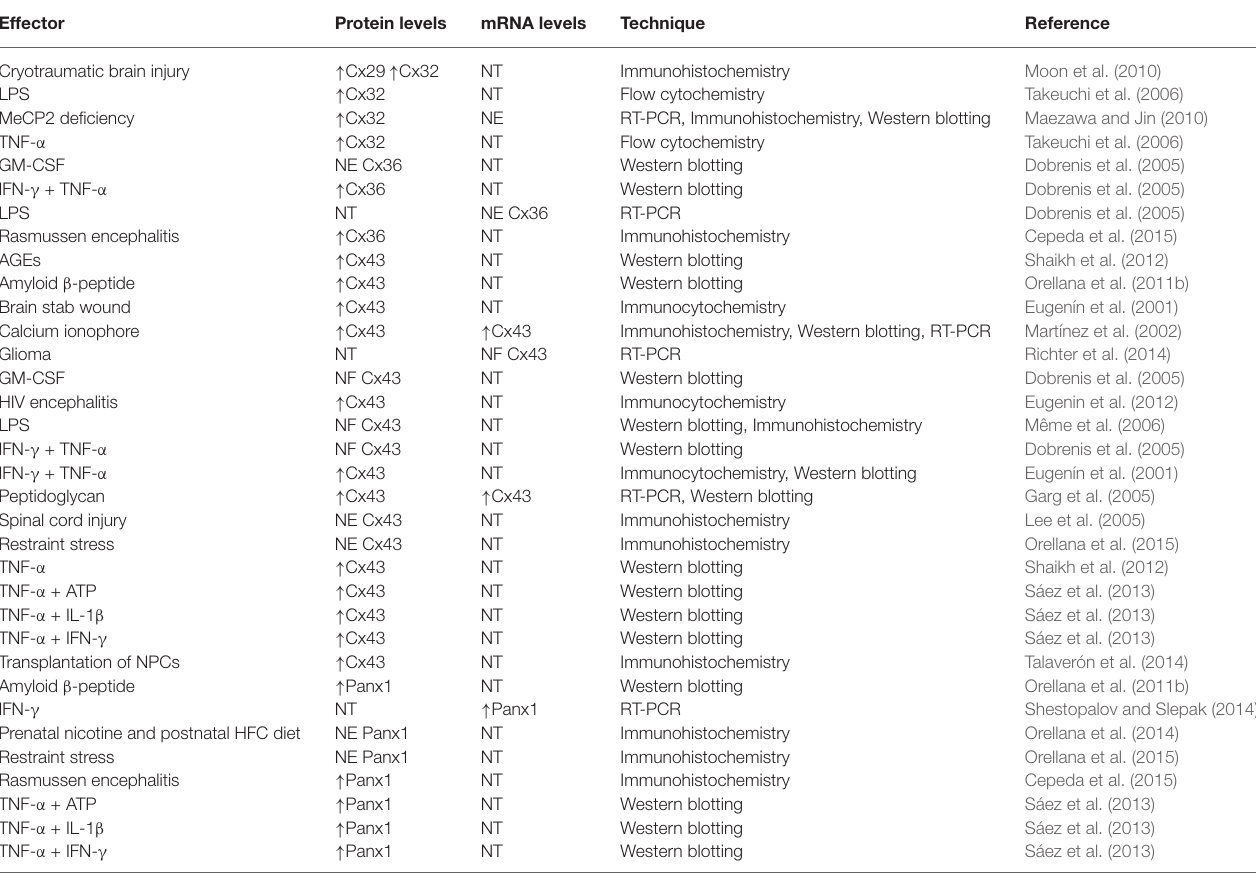
TABLE 1 | Regulation of connexin and pannexin expression in